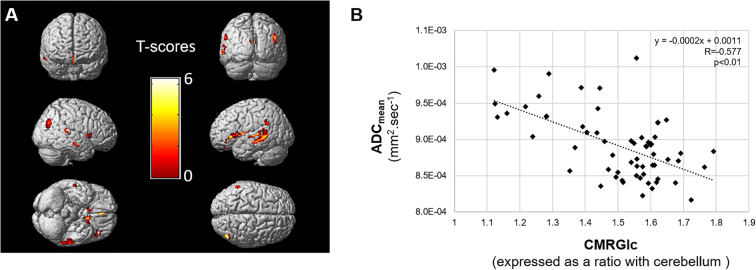
A Three-dimensional volume rendering images representing the grey matter areas for which the metabolic rate of glucose (CMRGlc) was significantly (p < 0.005, with minimum cluster size of 39 voxels) and negatively correlated with the mean apparent diffusion coefficient (ADCmean) of the overall white matter and by using age and gender as covariates (A). B: Linear and inverse relationship between the mean apparent diffusion coefficient (ADCmean) of the overall white matter and the global metabolic rate of glucose (CMRGlc) of the grey matter voxels involved in the significant area displayed in Fig. 1A.